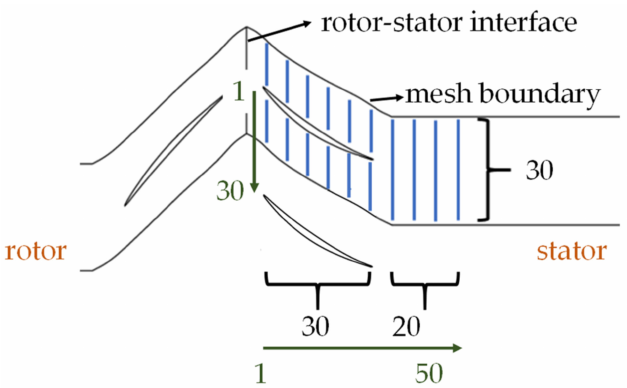
Figure 6. The setting of monitoring